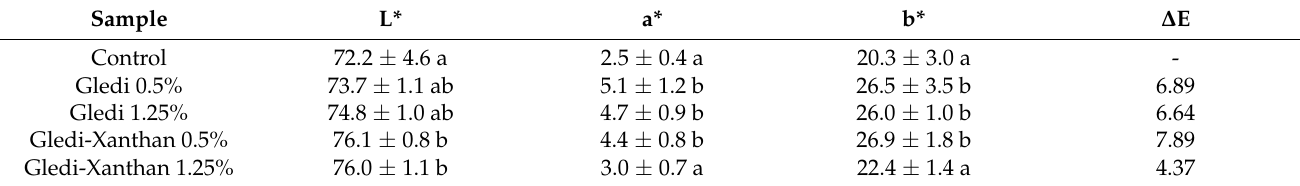
Table 7. Gluten-free bread crust